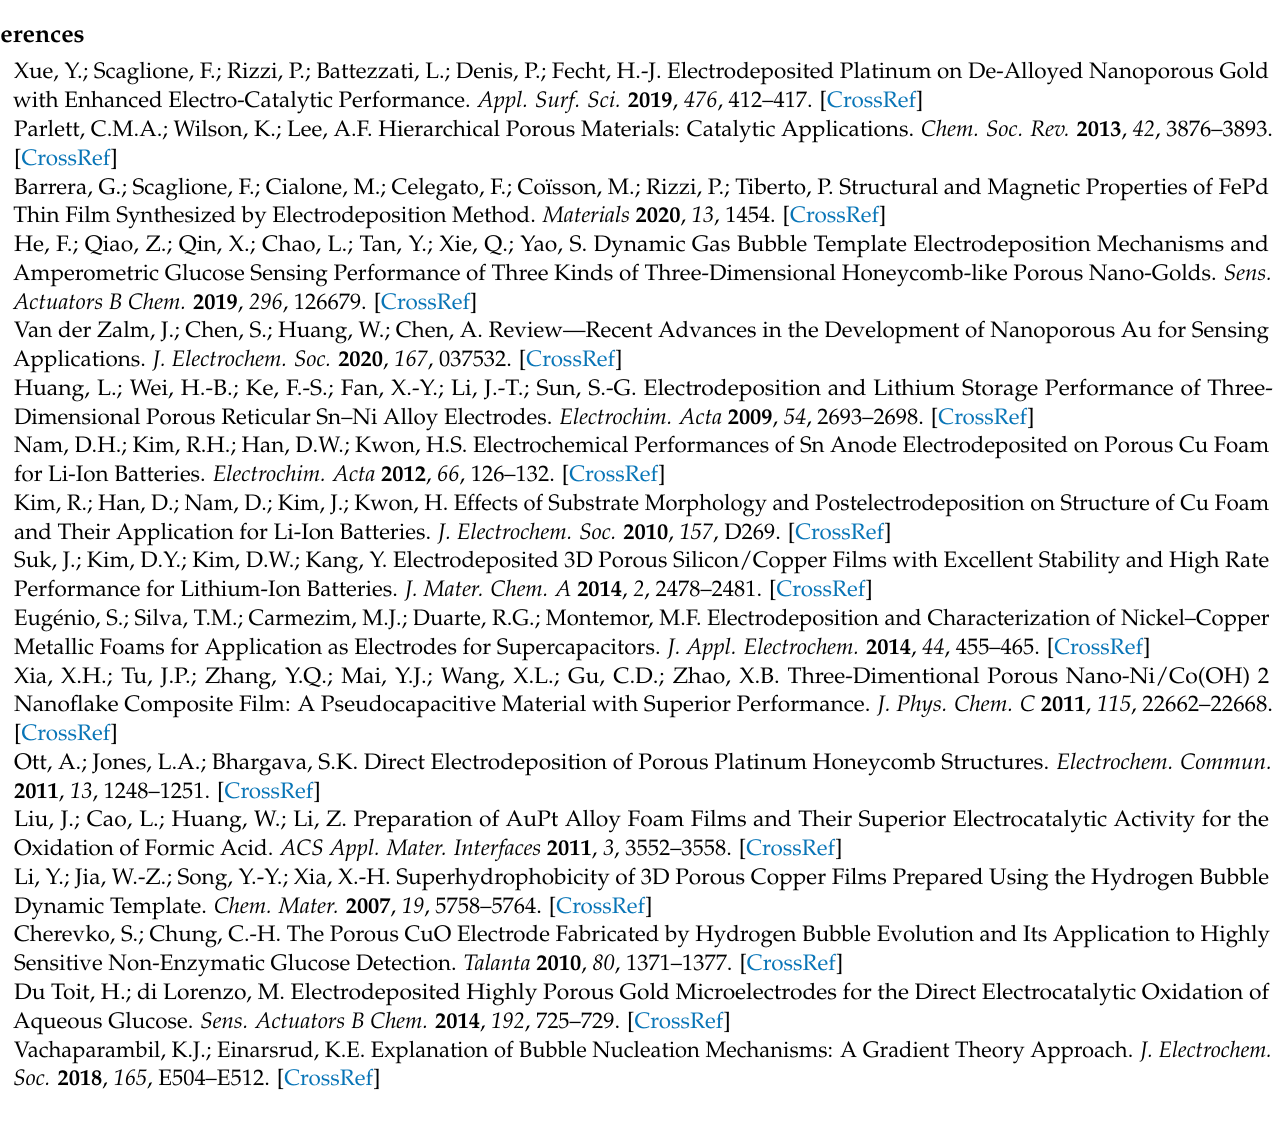
Figure S2: SERS spectra of Rhodamine 6G dye for different concentrations using (a) Fe90s, (b) Fe300s and (c) Pd90s as